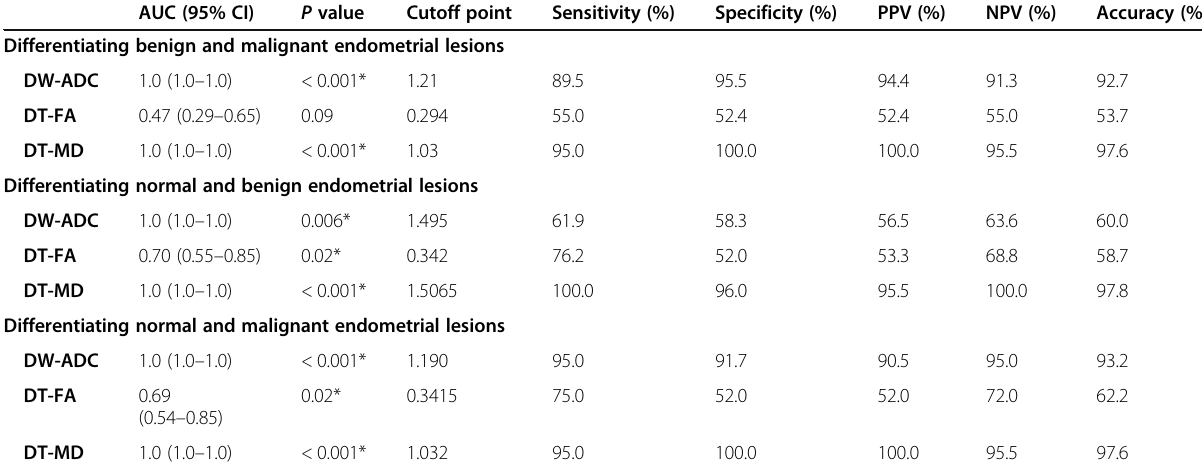
Table 4 The validity of DW-ADC, DT-FA, and DT-MD in differentiation of normal, benign, and malignant endometrium AUC (95% CI) P value Cutoff